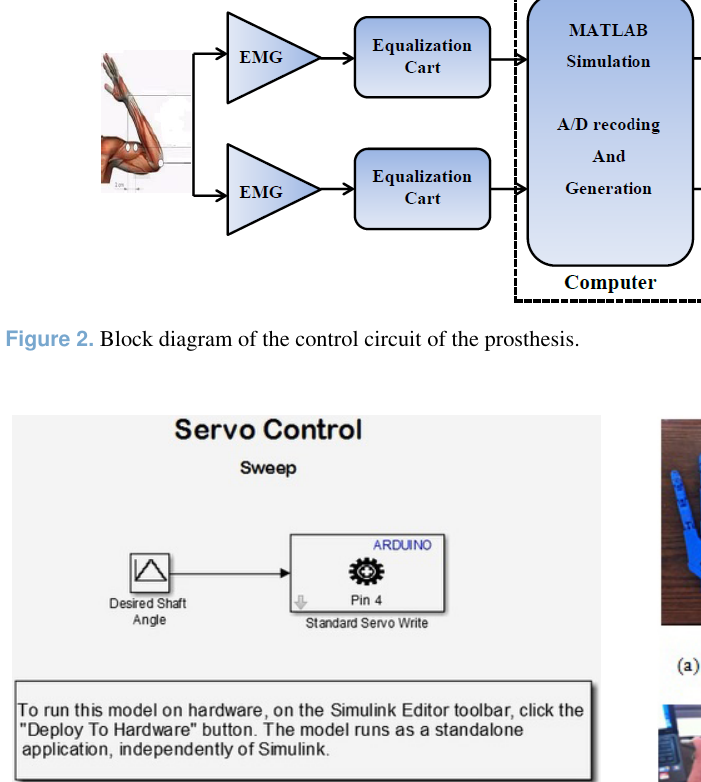
Figure 3. Arduino servo circuit schematic.